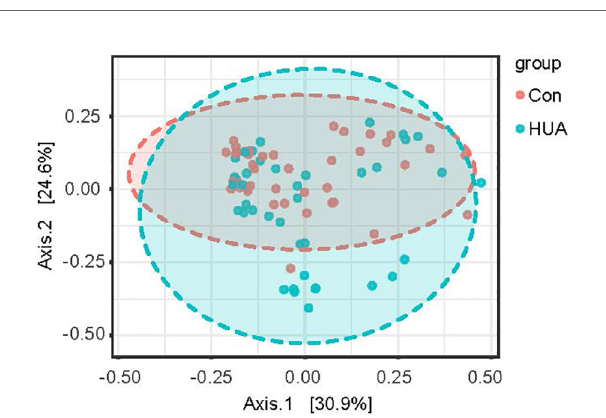
FIGURE 3 | PCoA plot of HUA and Con subjects. HUA, hyperuricemia;